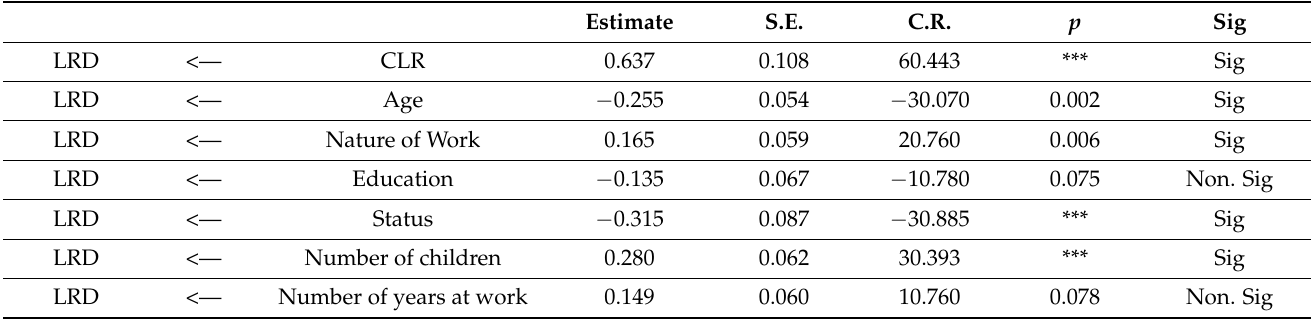
Table 6. Hypothesis